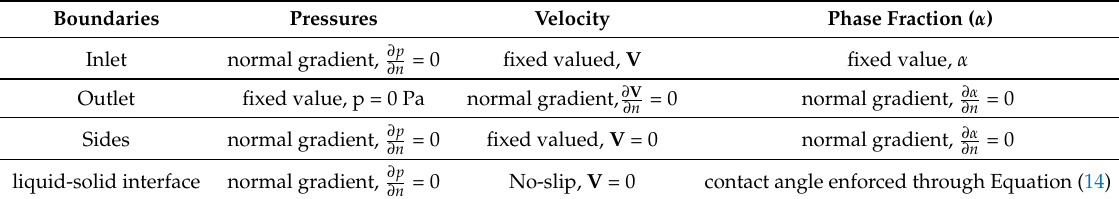
Table 1. Boundary